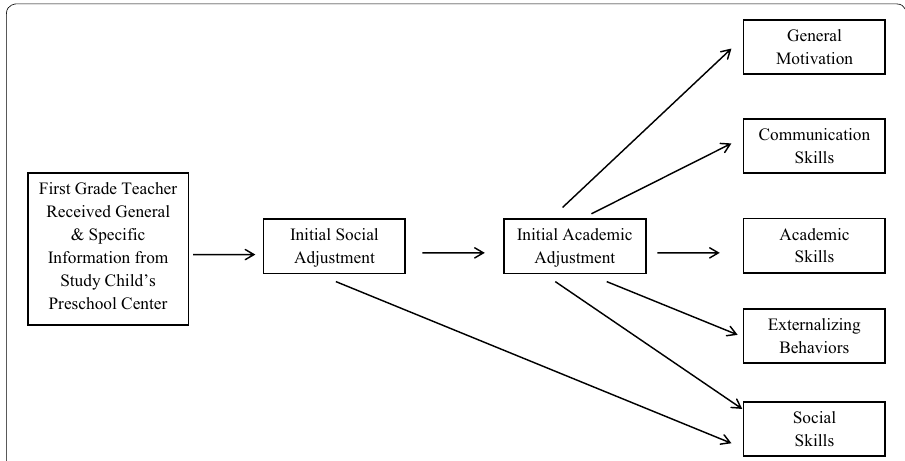
Fig. 1 Hypothesized teacher-center contact and child outcomes mediation